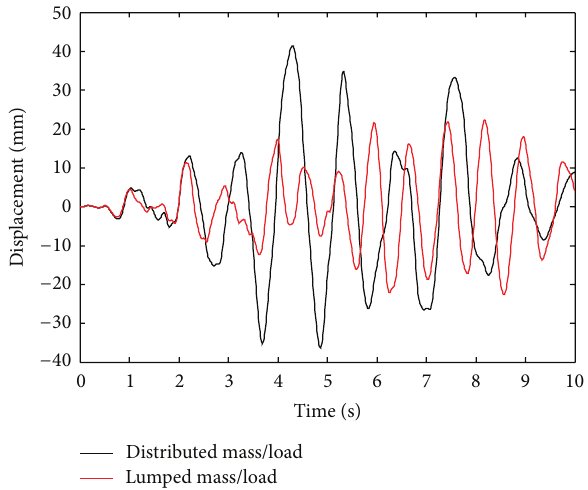
Figure 12: Horizontal displacement time history graphs of node 9 for lumped/distributed mass and load